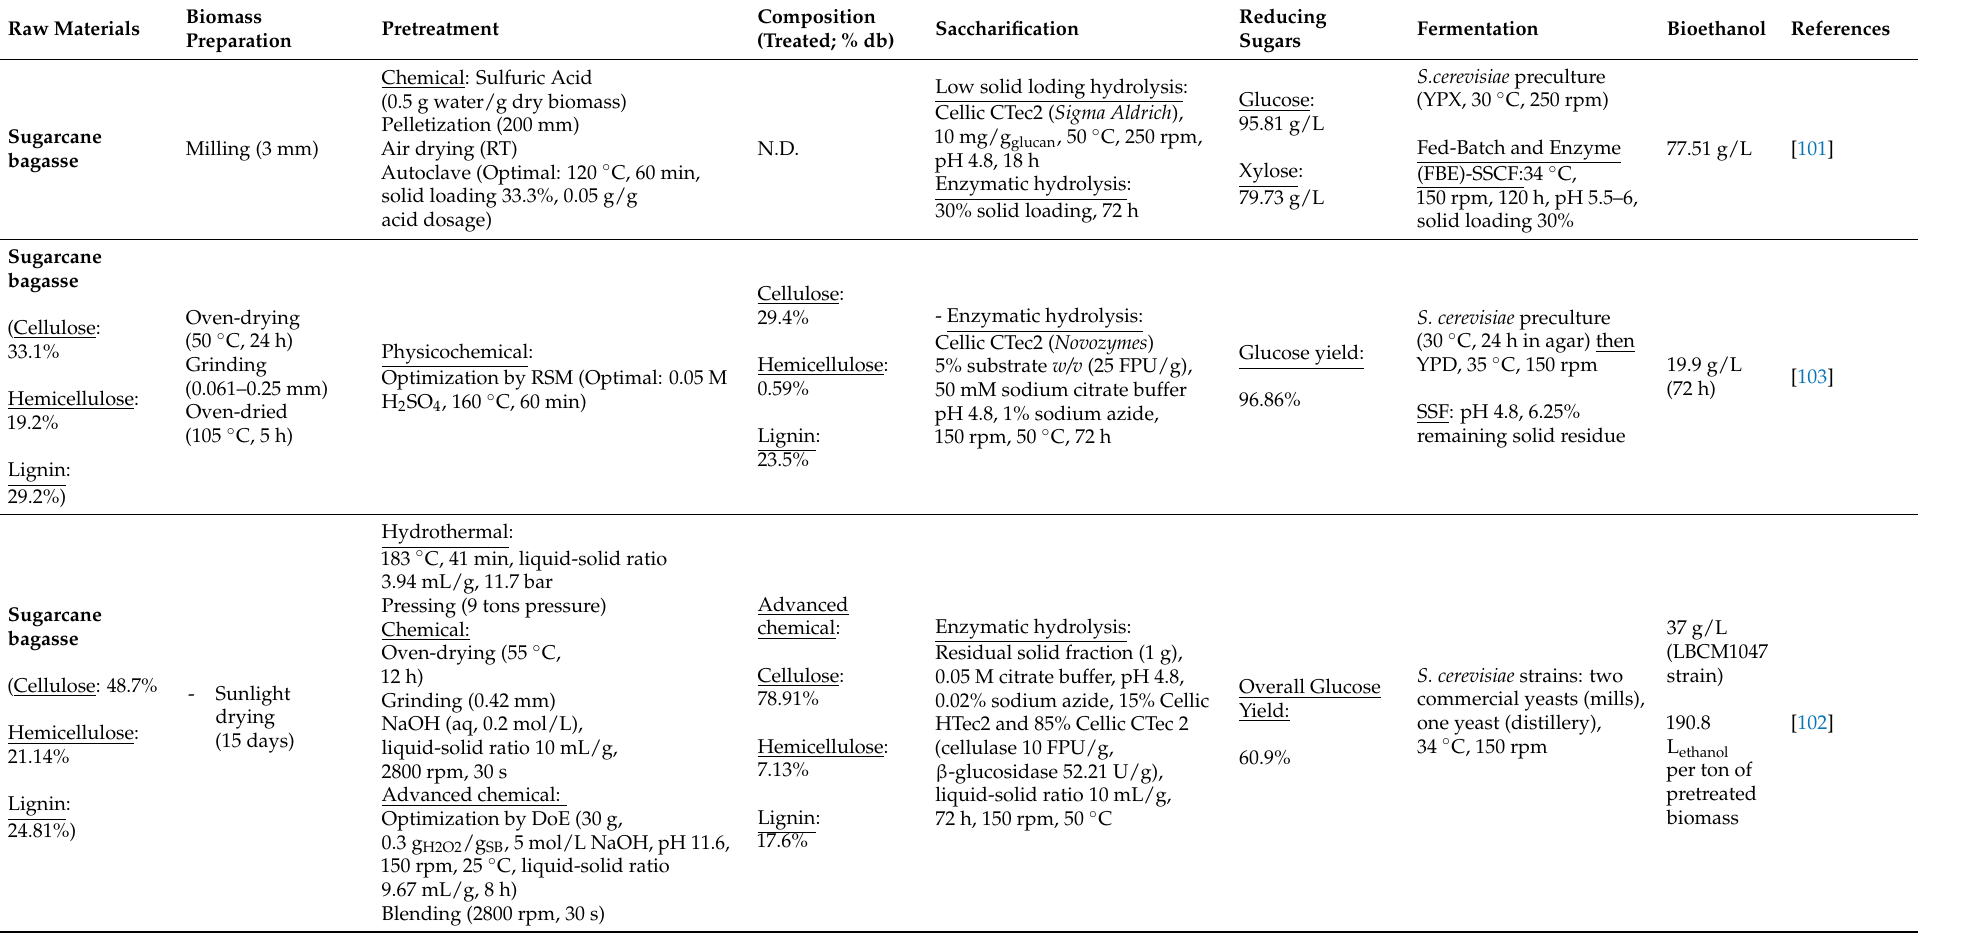
Table 6. Summary of experiments done for the pretreatment of sugarcane